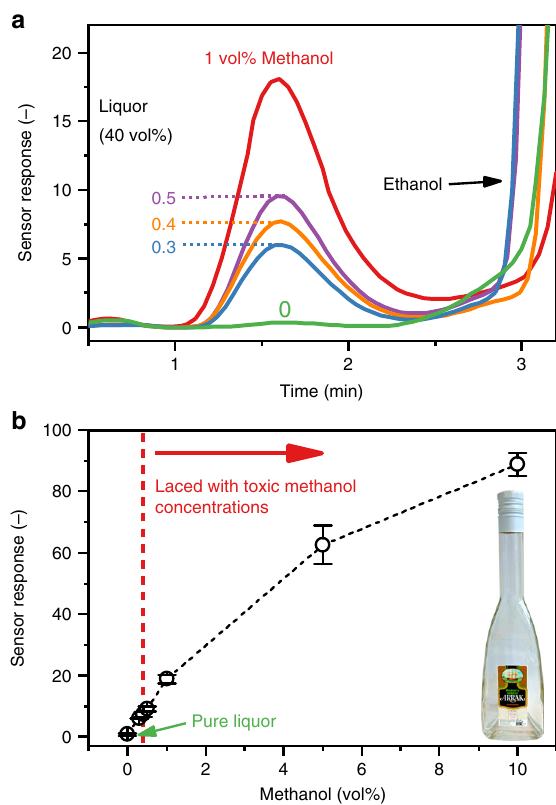
Fig. 5 Detection of methanol in laced liquor (Arrack). a Response of the detector to pure liquor (green line) containing 40 vol% ethanol and laced with methanol of 0.3 (blue line), 0.4 (orange line), 0.5 (purple line), and 1 vol% (red line). b Sensor responses as a function of methanol content (0 – 10 vol%) in the liquor (black circles). The red dashed line indicates the legally allowed (US 34 and EU 36 ) naturally occurring methanol content in liquor (40 vol% ethanol). Error bars indicate the standard deviation of at least three measurements (i.e., repeatability) with <15% variation (orange line), 0.5 (purple line), and 1 vol% (red line) methanol.